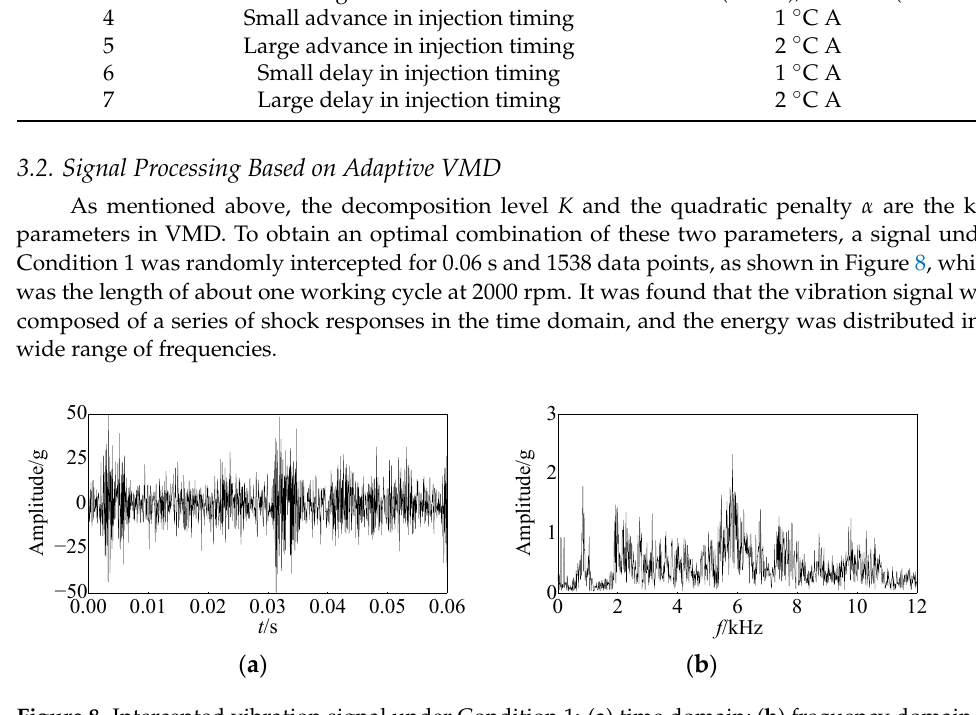
Figure 8. Intercepted vibration signal under Condition 1: ( a ) time domain; ( b ) frequency domain.